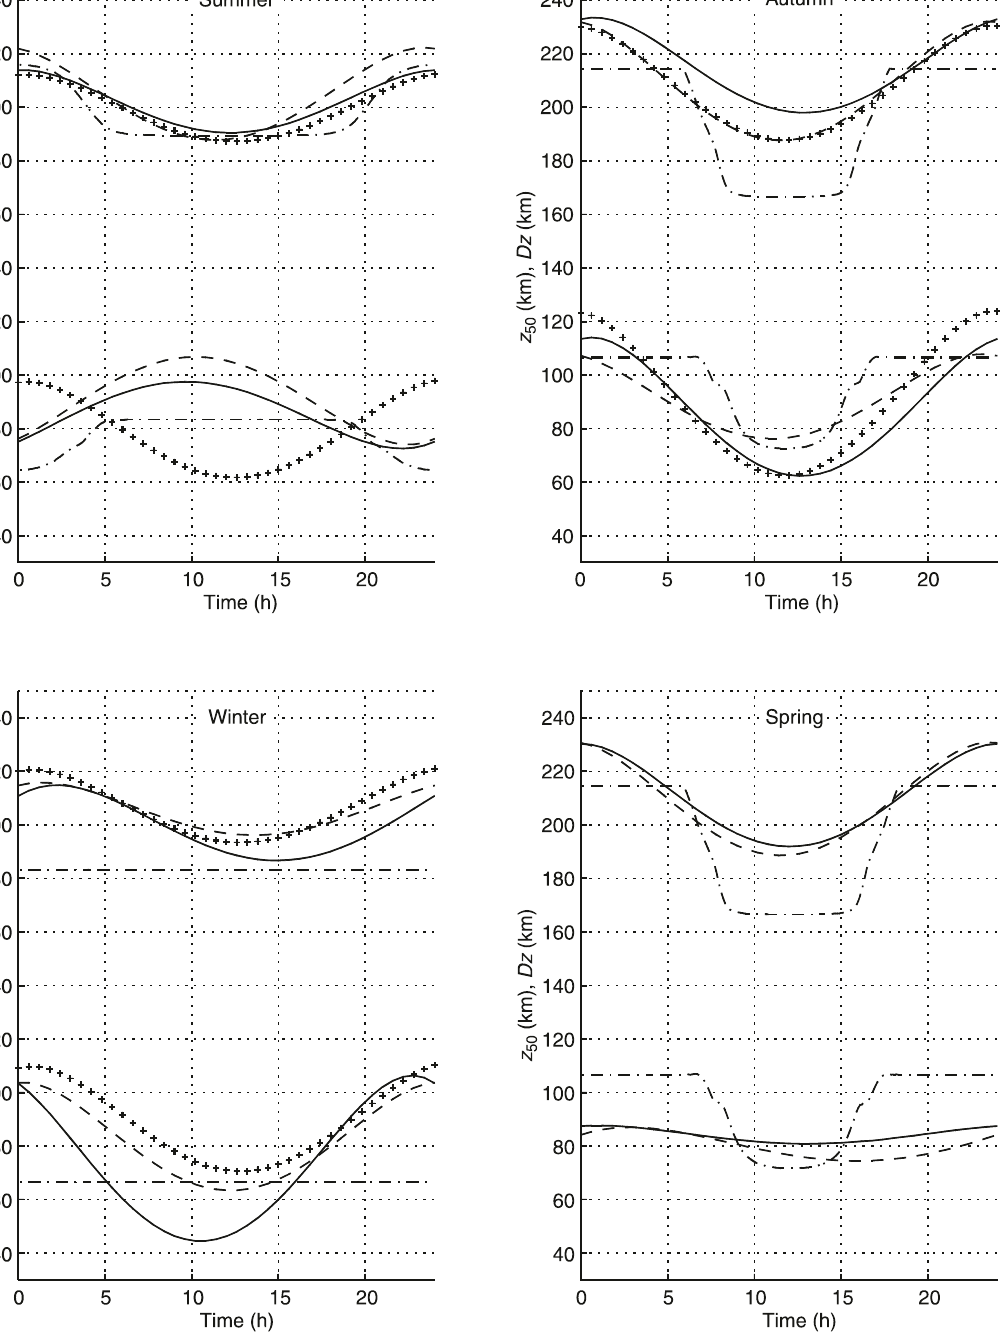
spring). The dash-dotted line corresponds to the IRI model for 100 < F 10 : 7